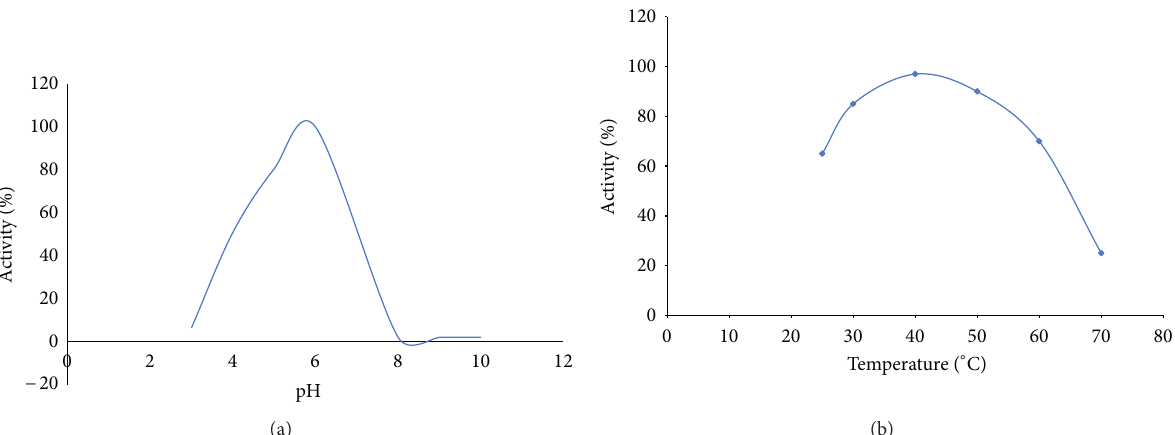
F 3: (a) p� pro�le for the activity of lipoxygenase from Cucumeropsis manii seeds. (b) Optimum temperature for LOX activity from C. manii .